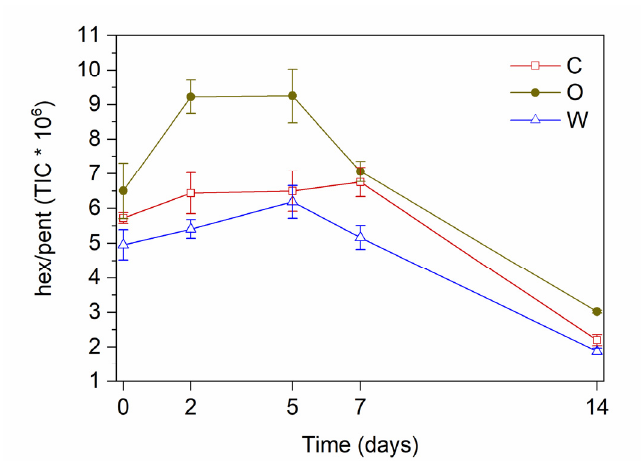
Figure 6. Hexanal/pentanal ratio during accelerated oxidation of O/W emulsions added with OPAs. Mean values ± standard deviation ( n = 3). C, control emulsion; O, emulsion with OPAs added to the oil phase; W, emulsion with OPAs added to the water phase.